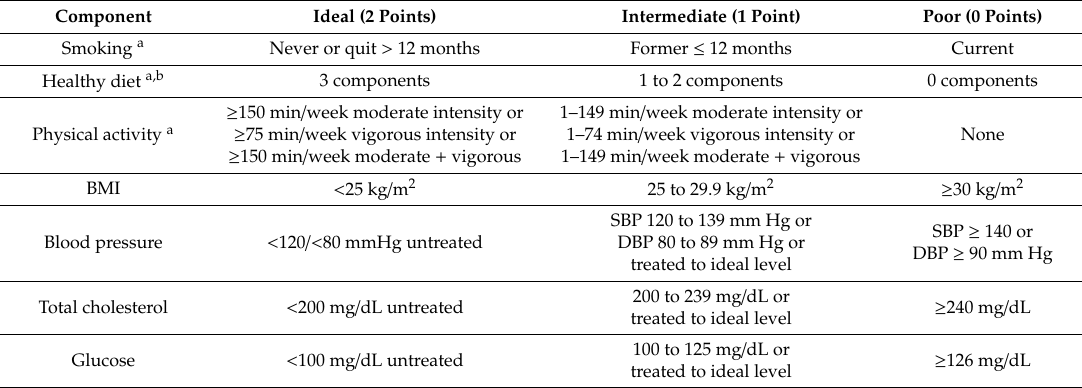
Table 1. Definitions of Ideal, Intermediate, and Poor Levels of Life’s Simple 7 (LS7) Components.